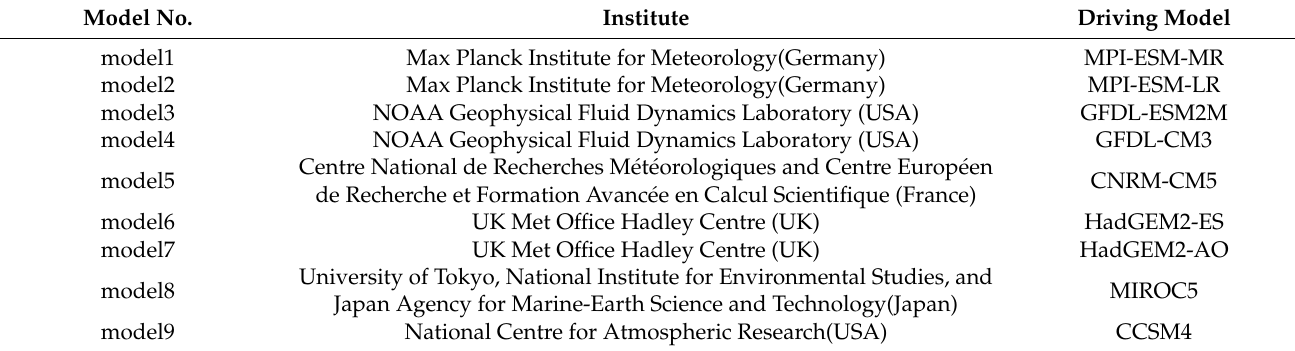
Table 1. The RCMs to be